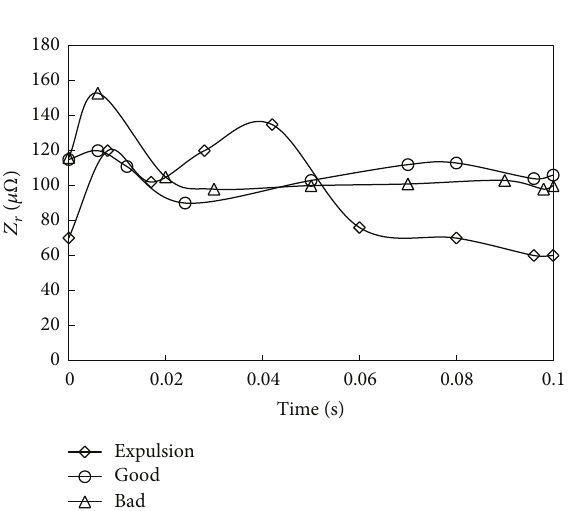
Figure 4: 𝑍 𝑟 (𝑡) of a typical resistance spot welding process.